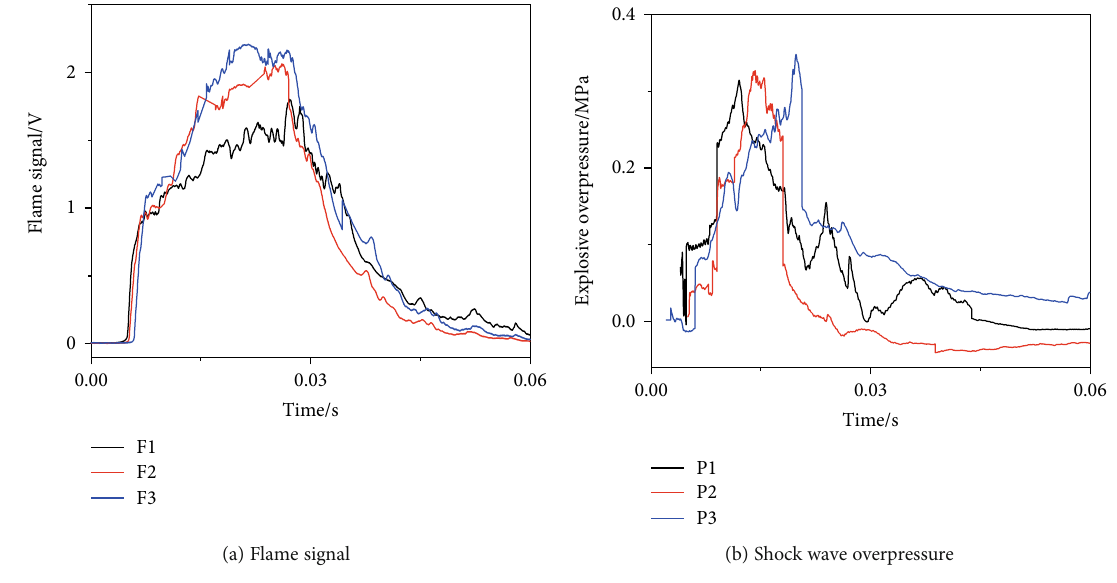
Figure 3: Explosion fl ame and shock wave overpressure.